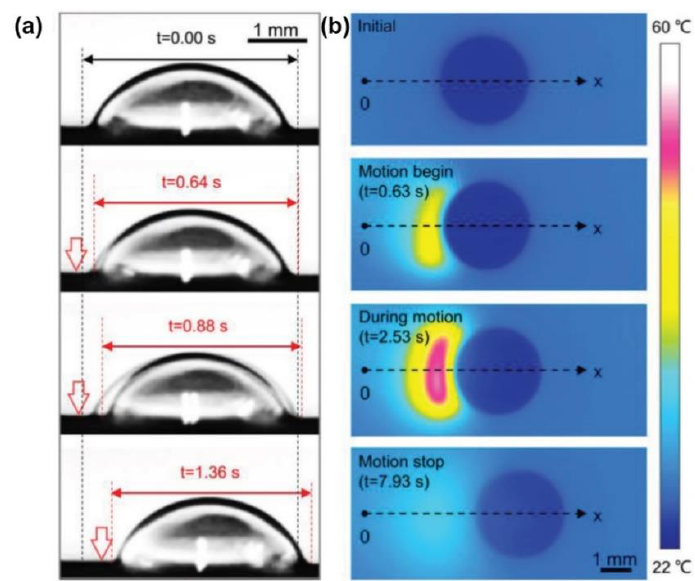
Figure 10. ( a ) Images of a propylene glycol droplet moving. The droplet’s left edge begins to shrink and moves towards the right under NIR. (vertical arrows). ( b ) Infrared images of 9 µ L water droplet on LIS The irradiated droplet begins to move along the x-axis at t = 0.63 s and stops at t = 7.93 s after NIR irradiation is switched off. Reprinted with permission from [40]. Copyright (2018) American Chemical Society.